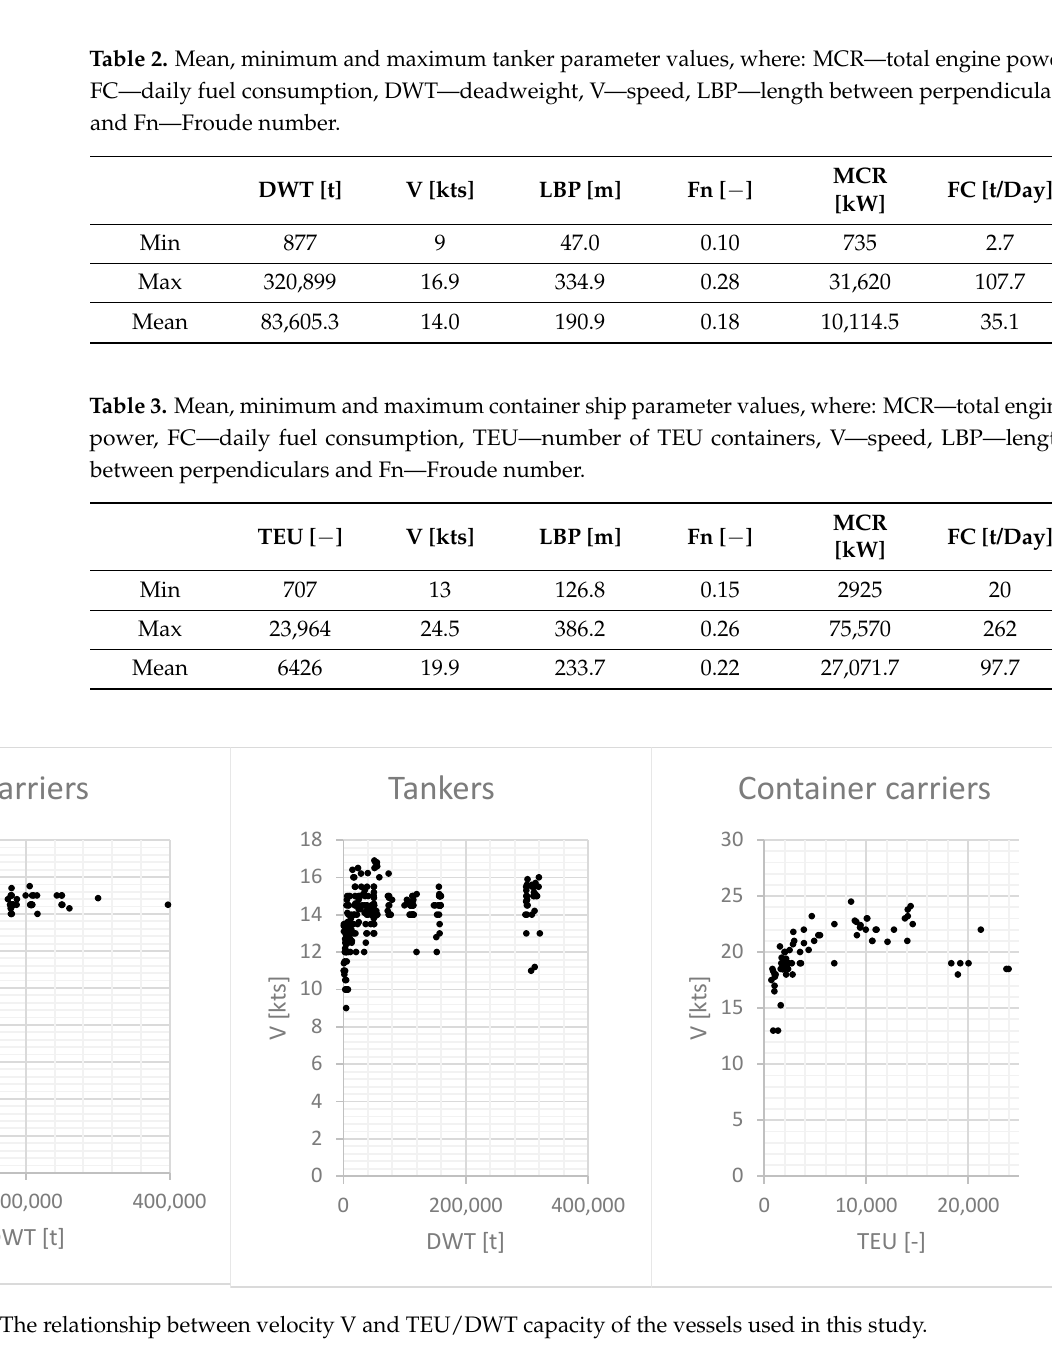
37.4 Table 2. Mean, minimum and maximum tanker parameter values, where: MCR—total engine power, FC—daily fuel consumption, DWT—deadweight, V—speed, LBP—length between perpendiculars and Fn—Froude number. DWT [t]